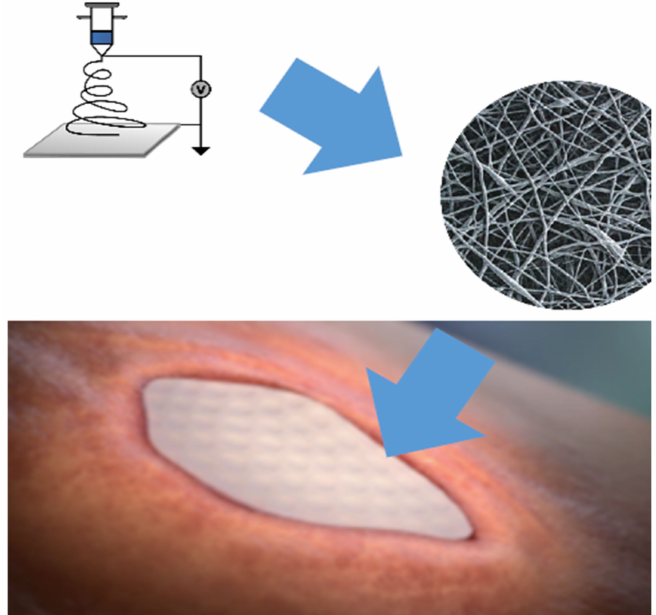
Figure 1. A graphical abstract demonstrating the electrospinning process and the microscopic appearance of the synthetic hybrid-scale fiber matrix, as well as its appearance in the wound